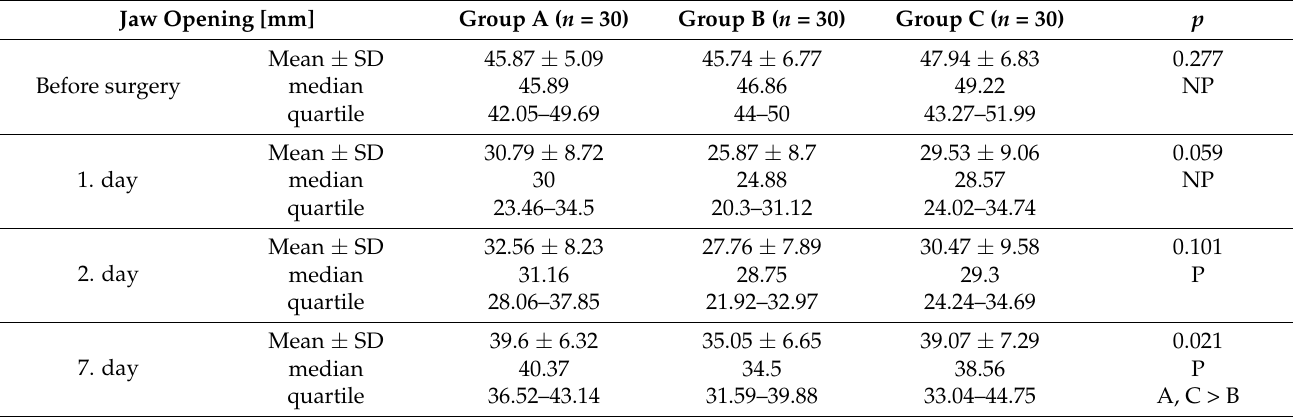
Table 4. Results of the comparative analysis of the level of jaw opening measured before surgery and on the following study days after surgery between groups A, B, C.